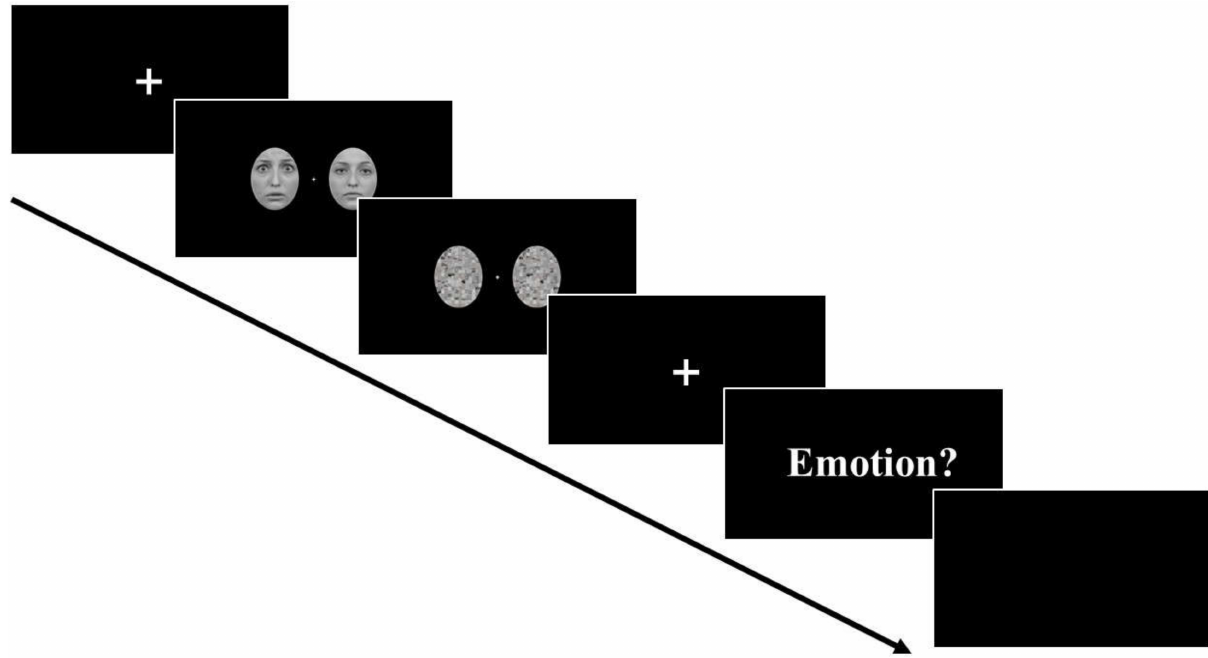
Figure 2. Time-course of events during a trial of the full experimental